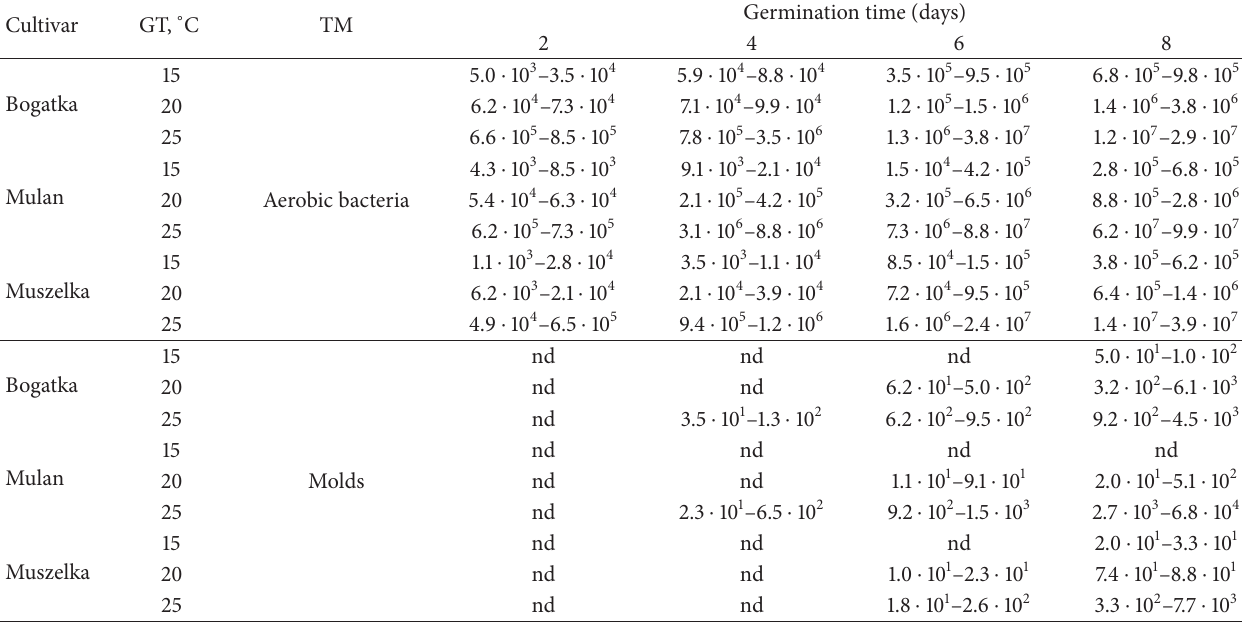
Table 2: The range of microbial load (cfu/g) on sprouts in relation to germination temperature and germination time. Cultivar GT, ∘ C TM